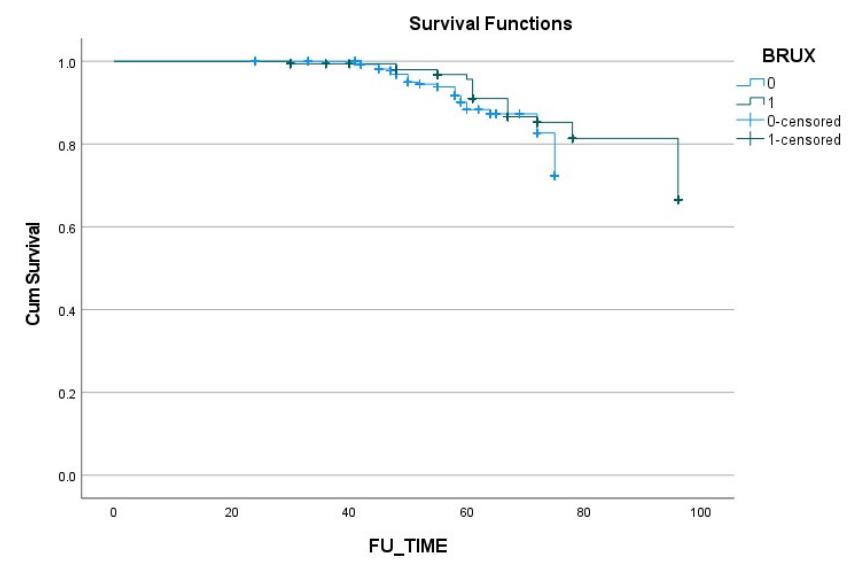
Figure 5. Kaplan–Meier overall survival rate combined with the complications that occurred .